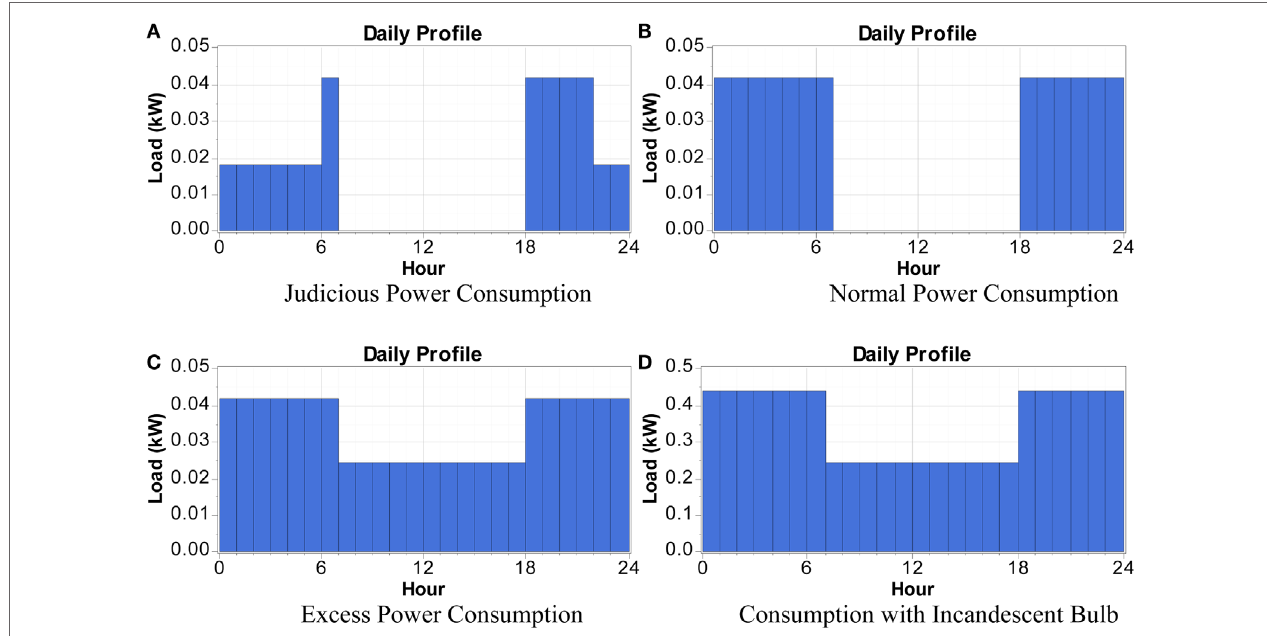
FigUre 2 | Daily lighting profile of the (a) judicious power consumption, (B) normal power consumption, (c) excess power consumption, and (D) consumption with incandescent bulb